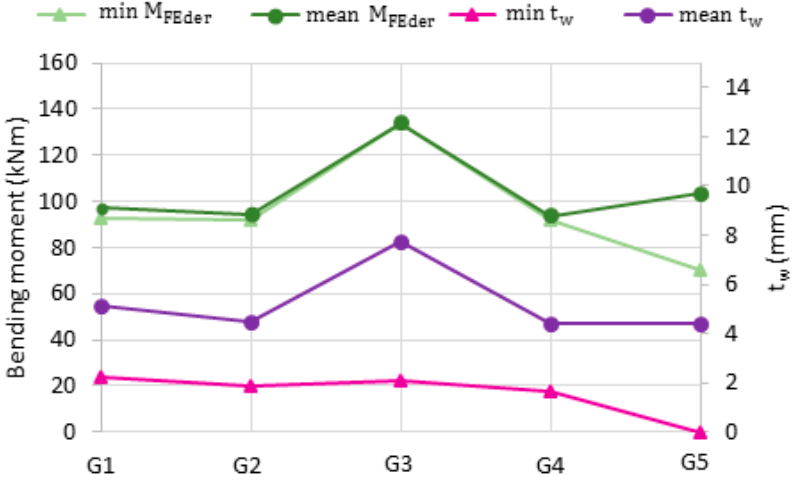
Figure 17. Minimum and mean values of web thickness ( purple ) and moment capacity ( green ) for derived beams samples.